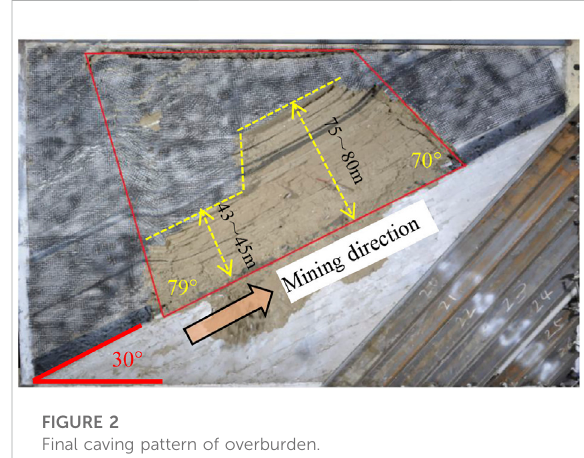
FIGURE 2 Final caving pattern of overburden.